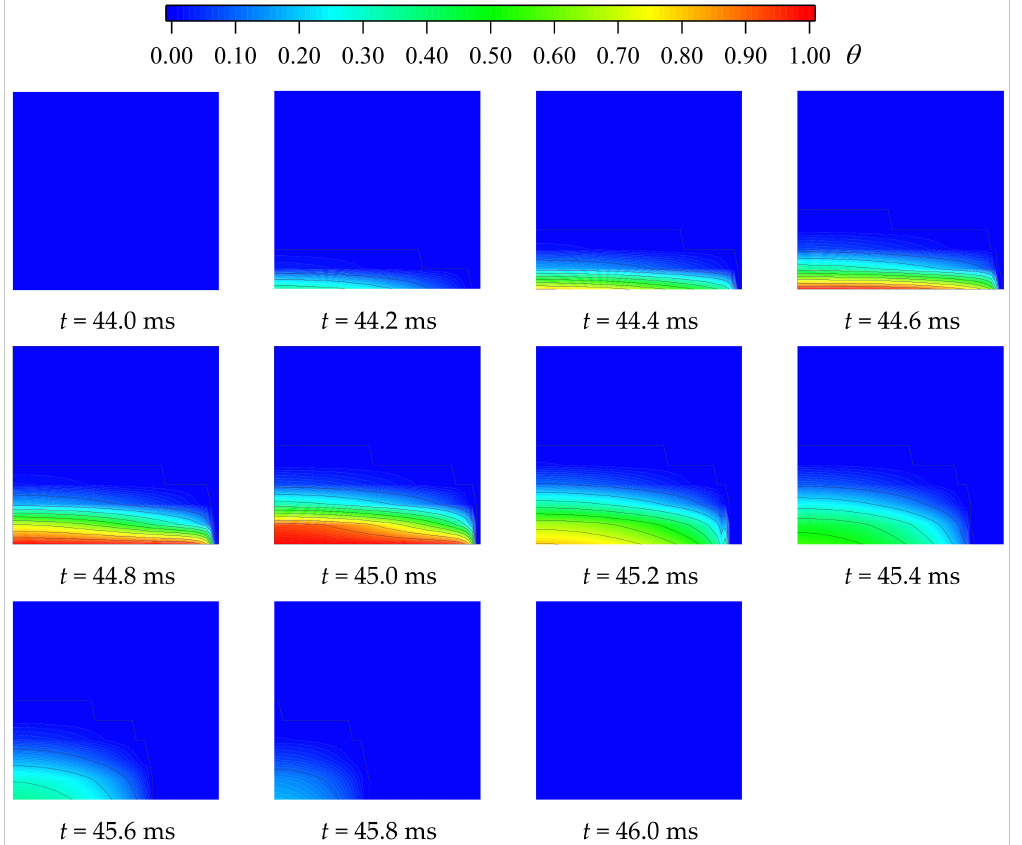
Figure 11. The phase change processes of metallic PCM during a heat pulse